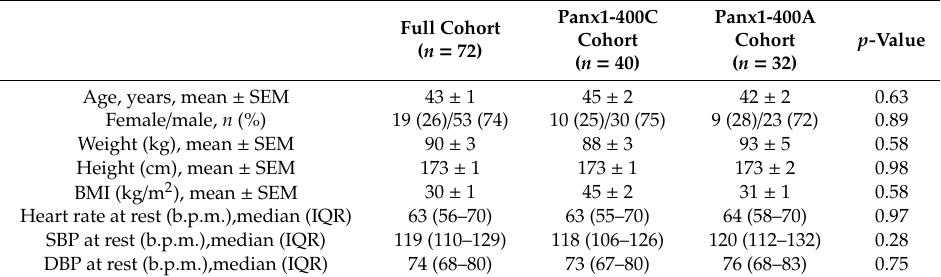
Table 1. Patient characteristics at the time of the inclusion in the